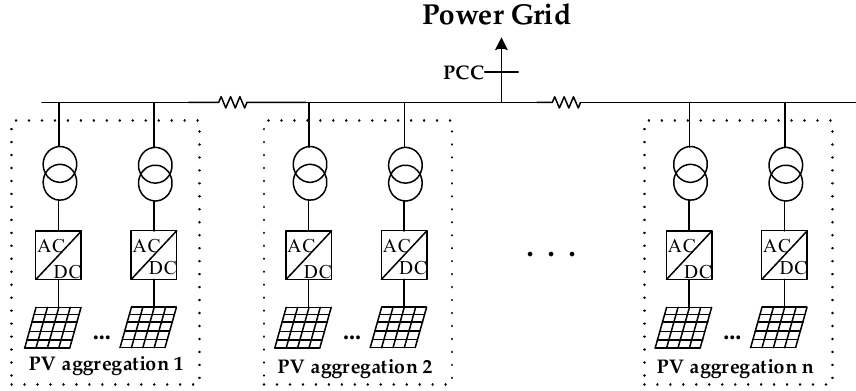
Figure 3. The schematic diagram of grouping result of a PV power plant.